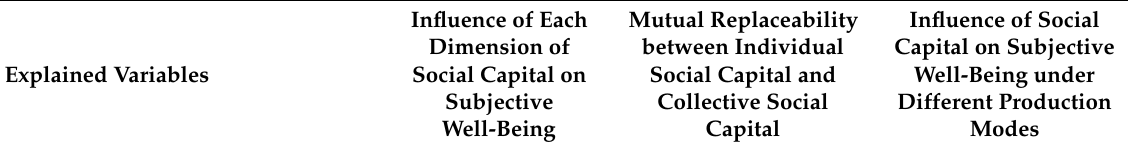
Table 5. Results of hypothesis